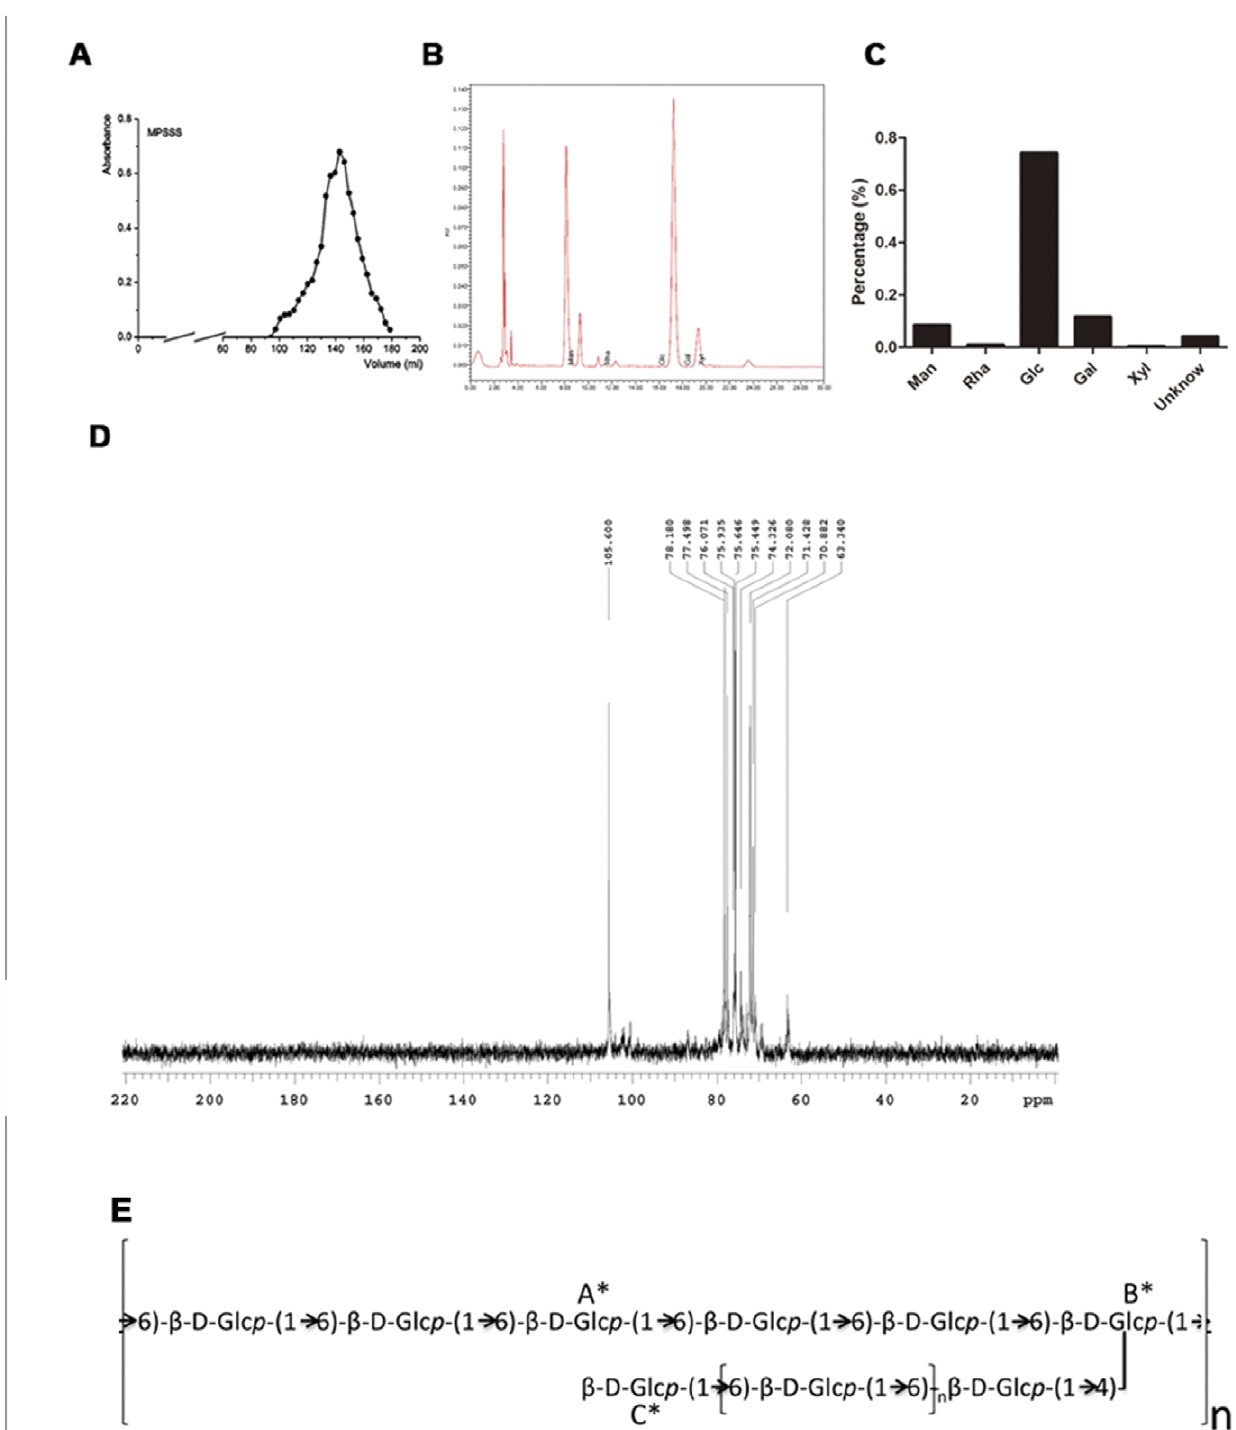
Figure 1. Composition and structure analysis of MPSSS. (A) MPSSS appeared as a single peak in Sepharose CL-6B chromatography, indicating its high degree of purity. (B) The monosaccharides derived from MPSSS were detected by HPLC. (C) Analytical results of the composition of MPSSS. (D) Results of 13 C NMR detection of MPSSS. (E) Analytical results of the MPSSS polysaccharide basic structure unit.